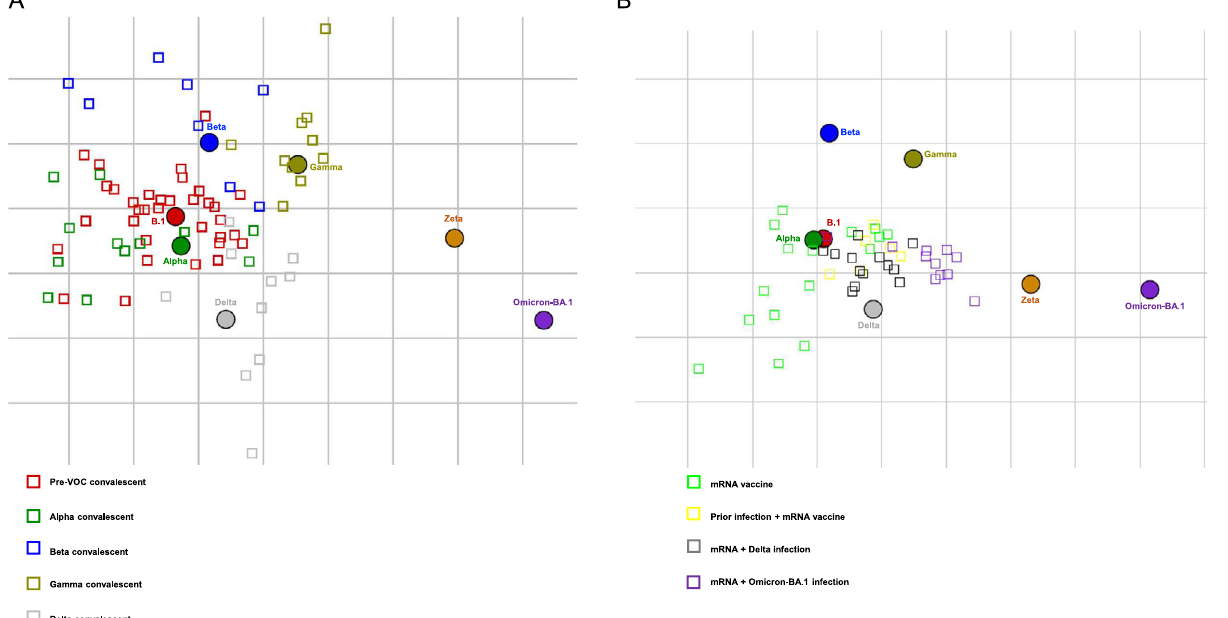
Fig. 3 SARS-CoV-2 antigenic cartography. Mapping of antigenic relationship using antigenic cartography for A convalescent specimens from pre-VOC SARS-CoV-2, Alpha, Beta, Gamma, and Delta infections and B post-vaccination specimens with and without prior infection and breakthrough infections with Delta or Omicron-BA.1. For graphical reasons only post vaccination specimens are shown in ( B ). Source data are provided as a Source Data fi le.